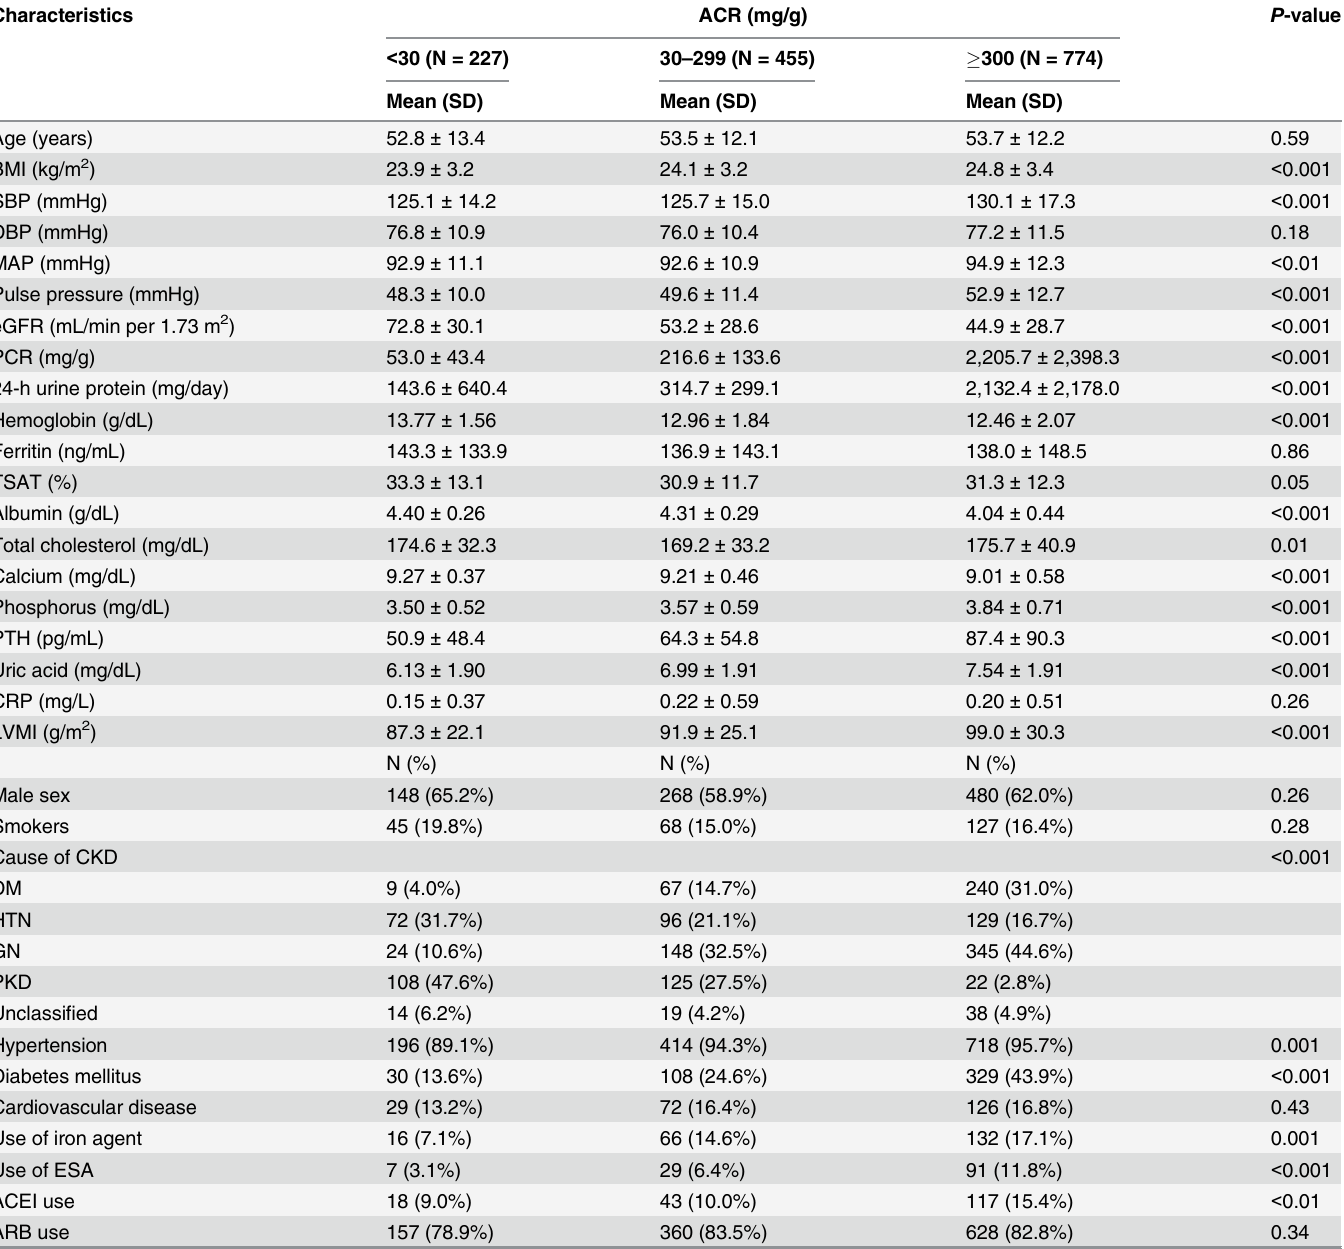
Table 1. Baseline characteristics of subjects according to